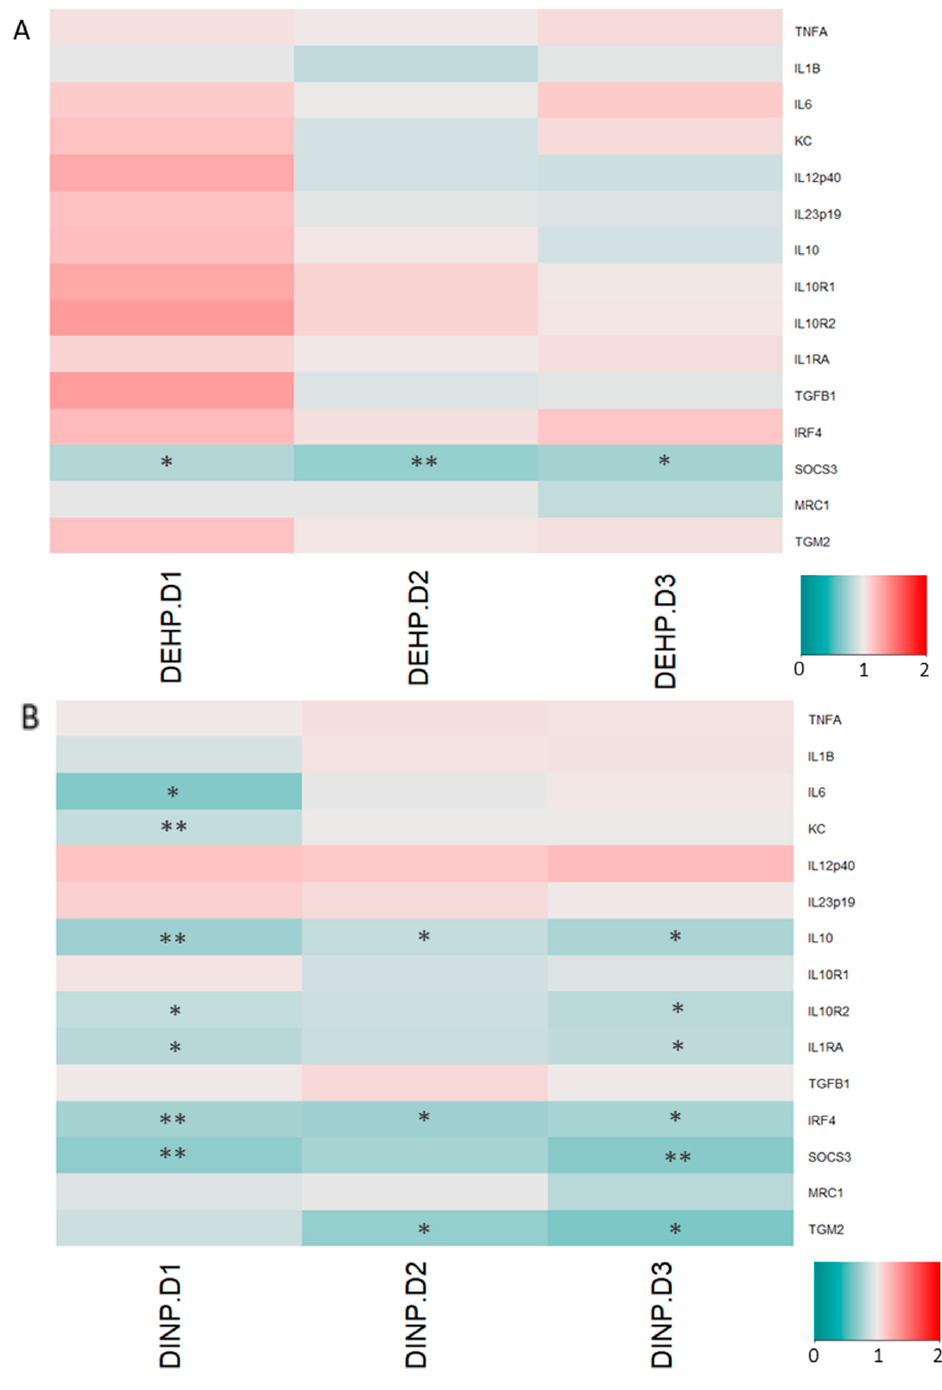
Figure 7. Relative quantification of cytokine mRNA levels in RAW264.7 after treatment of extracts from ( A ) DEHP fermenters and ( B ) DINP fermenters. Expression levels of mRNA in cells treated